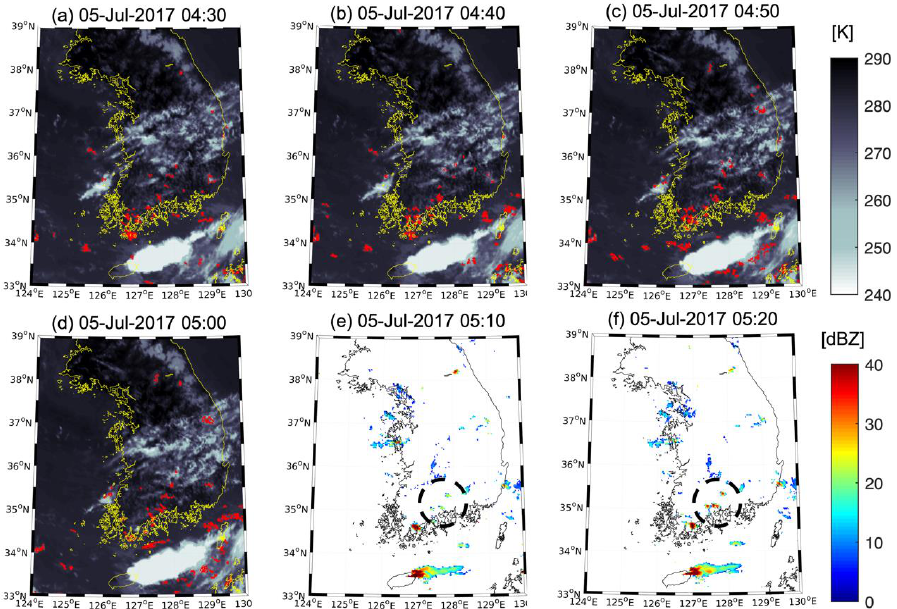
Figure 5. Time series of CI detection results ( a – d ) and radar CAPPI echoes ( e , f ) on 05 July 2017 (CI-B2) from 04:30 to 05:20 after model tuning. In ( a – d ), the predicted CI area is shown in red with T b (11.2) µ m as a background. The area over the target CI events is marked with a black circle in ( e , f ). The first ≥ 35 dBZ of radar echo over the target CI events occurred at 05:20 ( f ).